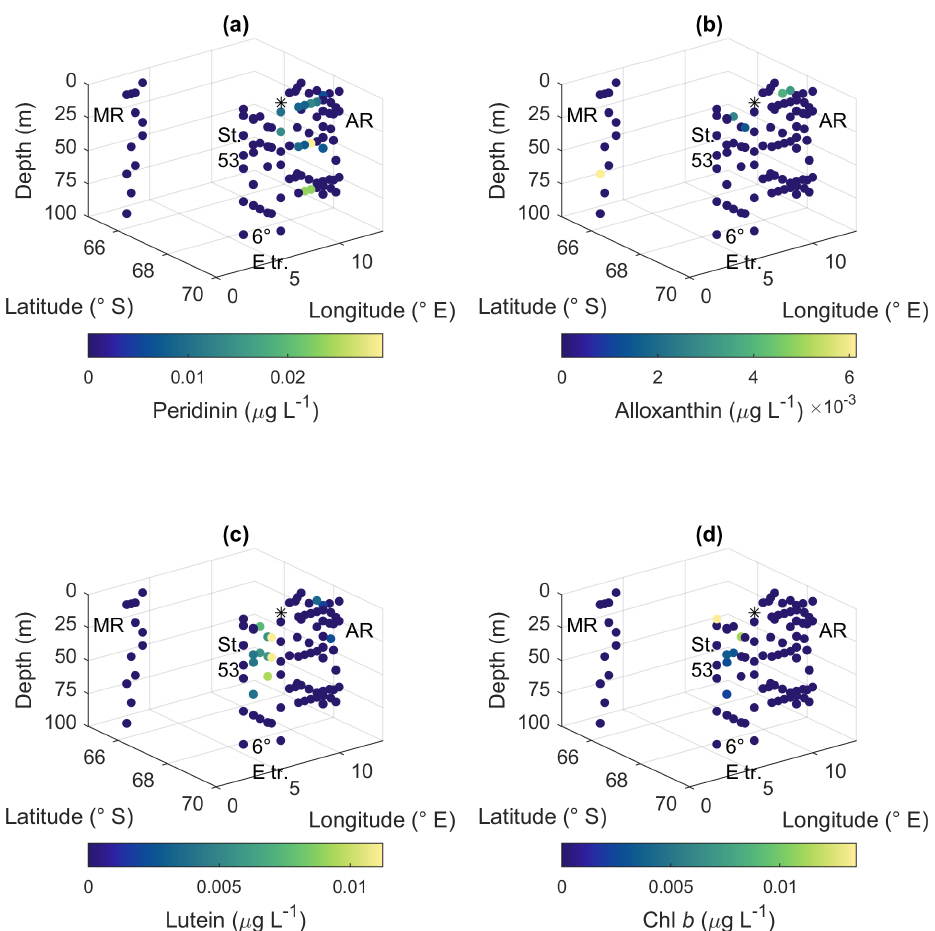
Figure A12. Pigment concentrations of (a) peridinin, (b) alloxanthin, (c) lutein and (d) Chl b . MR: Maud Rise, St. 53: station 53, AR: Astrid Ridge, 6 ◦ E tr.: 6 ◦ E transect. Station 54 is marked with a black asterisk.